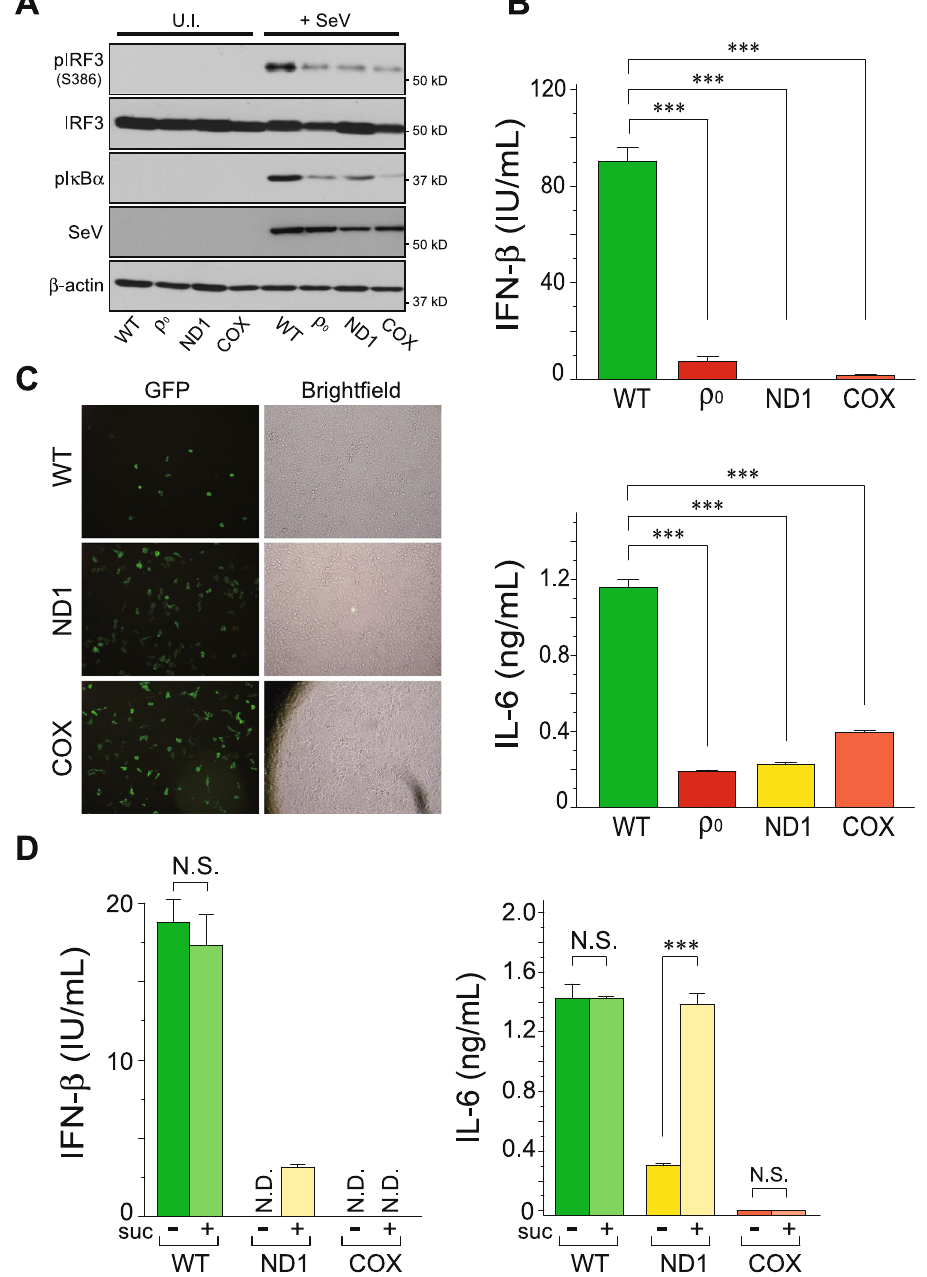
Figure 4. Defects in mtDNA cause malfunction in antiviral innate immunity. ( A , B ) The 143B cybrids and ρ 0 cells were infected with SeV (5 HAU/mL) for 18 h, and ( A ) activation of both IRF-3 and I κ B α was analyzed by Western blotting with antibodies against its specific phosphorylated-detection antibodies (Ser386 for IRF-3 and Ser32/36 for I κ B α ) or ( B ) the cell-free supernatants were analyzed by ELISA to measure the secreted amounts of IFN- β (top panel) and IL-6 (bottom panel). U.I., uninfected. Error bars indicate SD ( n = 3; Unpaired t -test; *** P < 0.001). ( C ) Fluorescence microscopy of 143B cybrid cells infected with IAV-GFP (0.6 HAU/mL) for 24 h. In ( A – C ), cells were maintained in ρ 0 medium. ( D ) Similar to ( B ), except that succinate (suc), the complex II substrate with ADP, was added to the oxidative medium as indicated. Error bars indicate SD ( n = 3; Unpaired t - test; *** P < 0.001; N.D., not detected; N.S., not